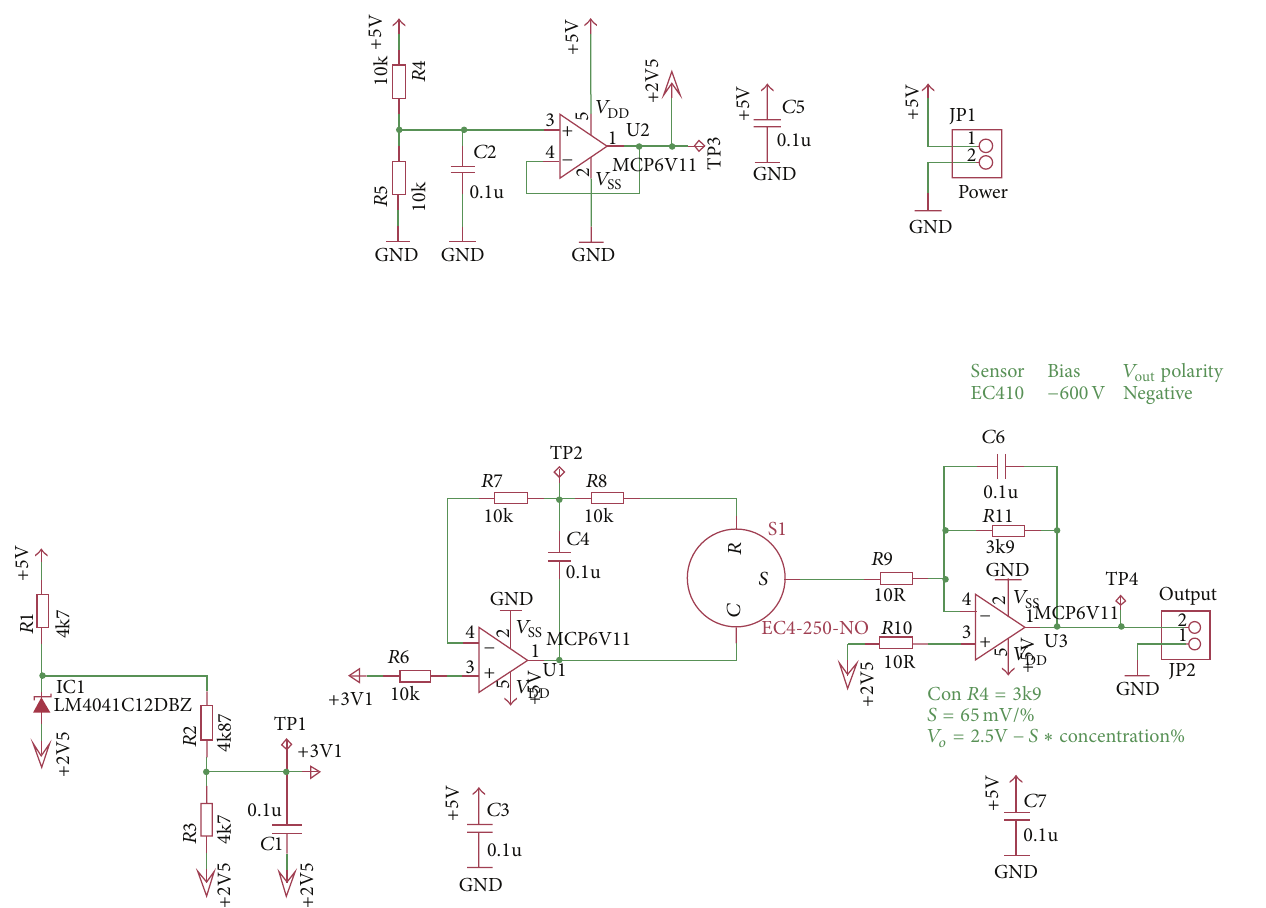
Figure 5: Circuit designed for O 2 Conditioning